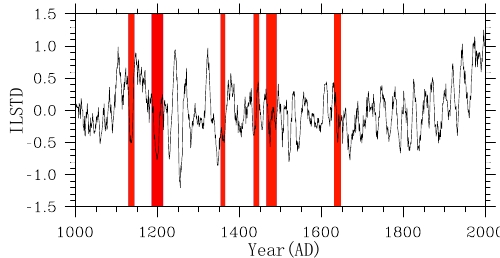
Figure 5. The 10-year running mean time series of standardized anomaly variations for the index of land–sea thermal difference (IL- STD). Six well-captured severe decadal droughts occurred during the periods 1129–1144, 1186–1214, 1354–1365, 1435–1448, 1466– 1491 and 1631–1648 are shown with red